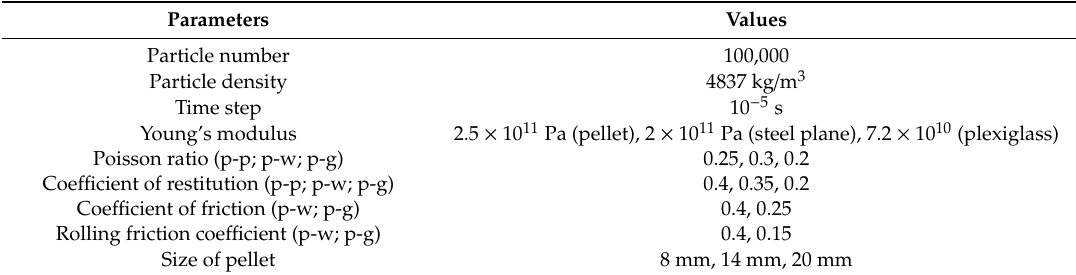
Table 2. Physical and contact parameters used in DEM simulation, including pellet particle and